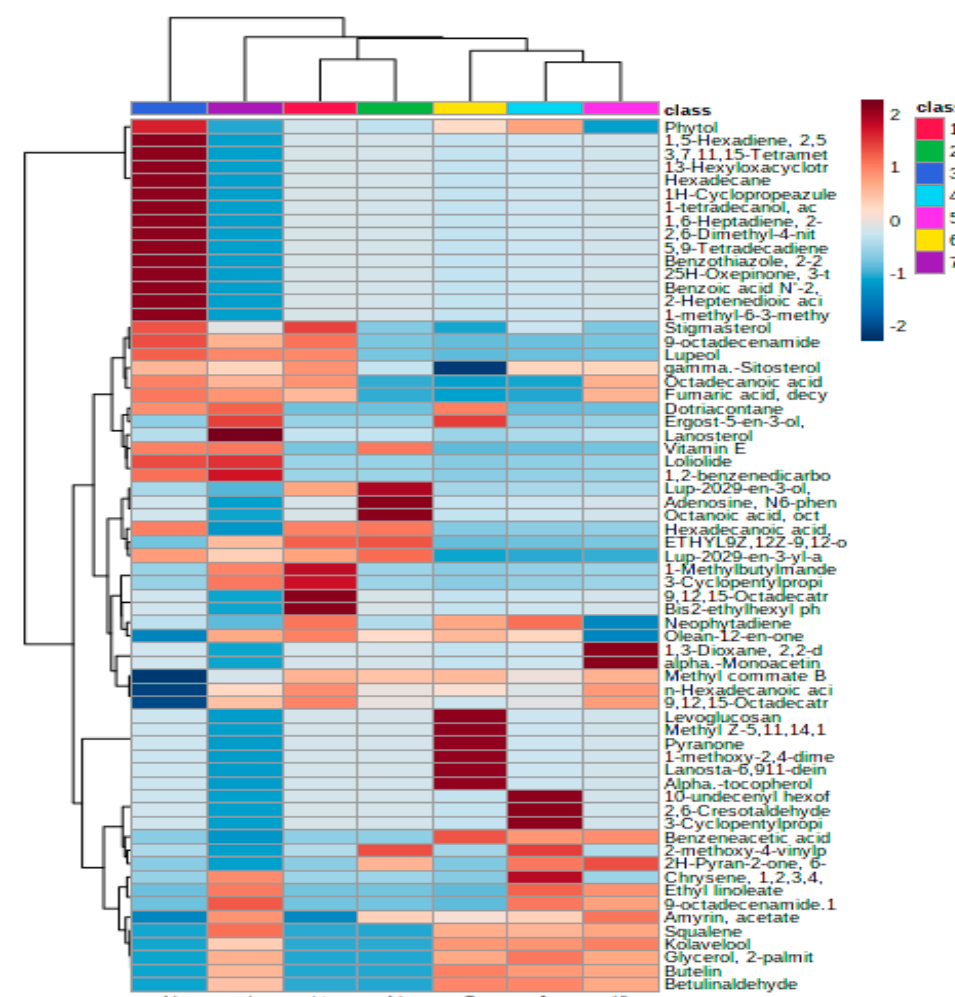
Figure 3. Heat map of the normalized response ratios of leaf metabolite areas in chicory accessions in response to different altitudes. Data of the content value of each compound were normalized to complete linkage hierarchical clustering. Each altitude is visualized as a single column and each metabolite is represented by a single row. Red indicates high abundance, whereas low relative compounds are shown in blue (color key scale on the right of the heat map).